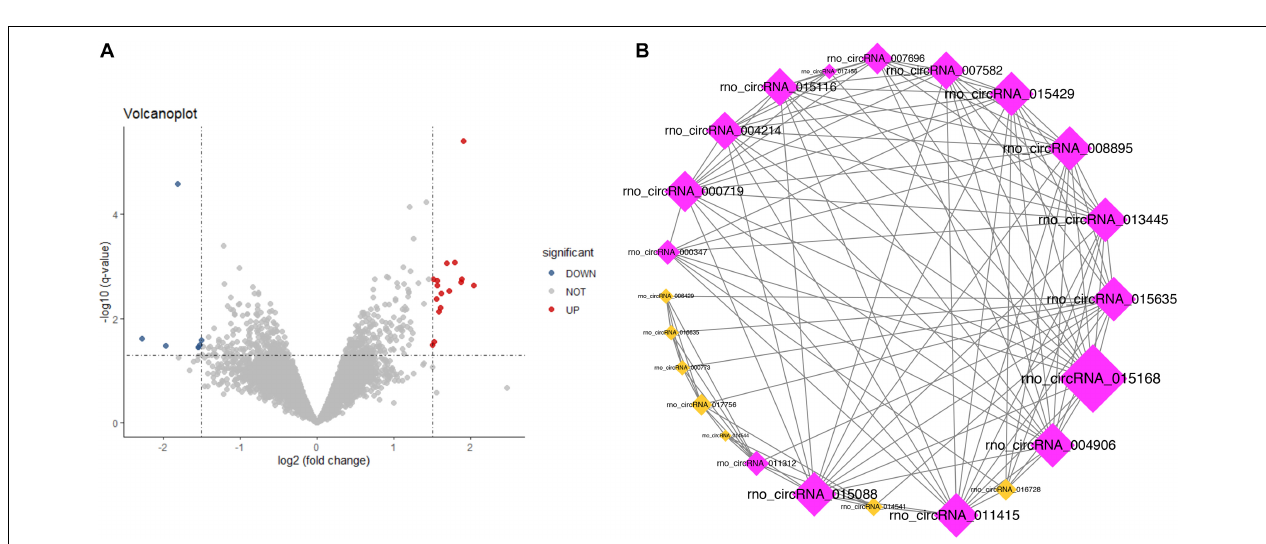
FIGURE 5 | Receiver operating characteristic curves of the five-gene signature. (A) HECTD1. (B) SRSF5. (C) SRSF1. (D) HERC2. (E) TNPO1.